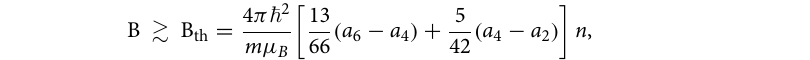
Figure 1. Upper frame: Condensate fraction of 52 Cr gas in the m s time. Three sets of data represent three successive steps of the cooling procedure. Simulations were performed at magnetic fields chosen according to the rule: 2 µ B B beginning of the cooling procedure. Hence, the magnetic field equals 1.75 mG for all cooling steps. Lower frame: Schematic diagram of time sequence of cooling event: ( A )—a thermal sample of atoms is prepared, ( B )—active cooling begins, ( C )—active coolings stops, ( D )—unwanted atoms are